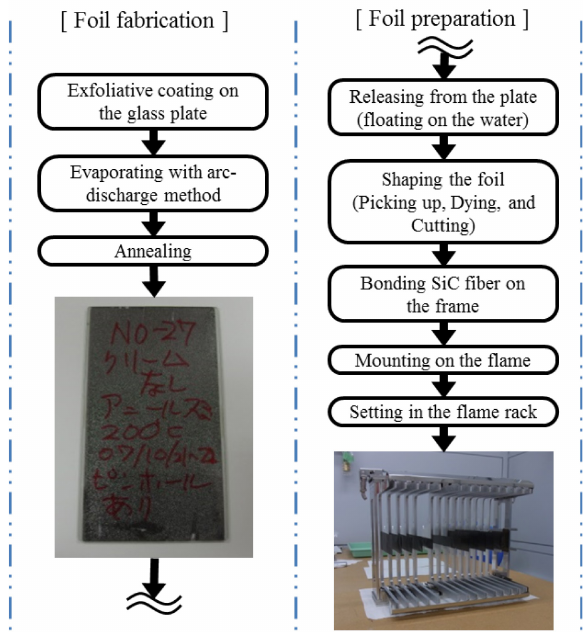
Fig. 2. Schematic diagram of foil manufacturing